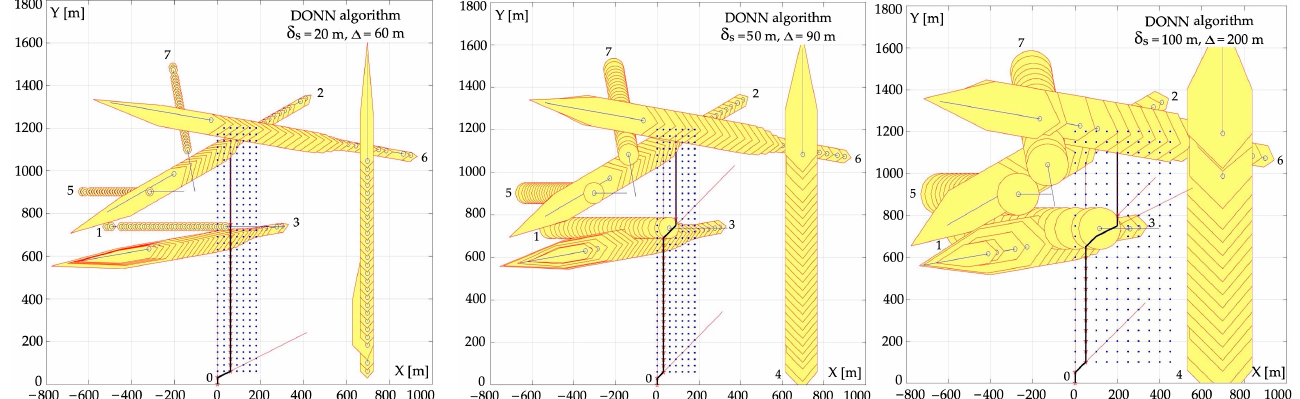
Figure 9. Safe dynamic trajectory of our autonomous vehicle in multidirectional traffic while passing seven other autonomous vehicles for three safe passing distance values.